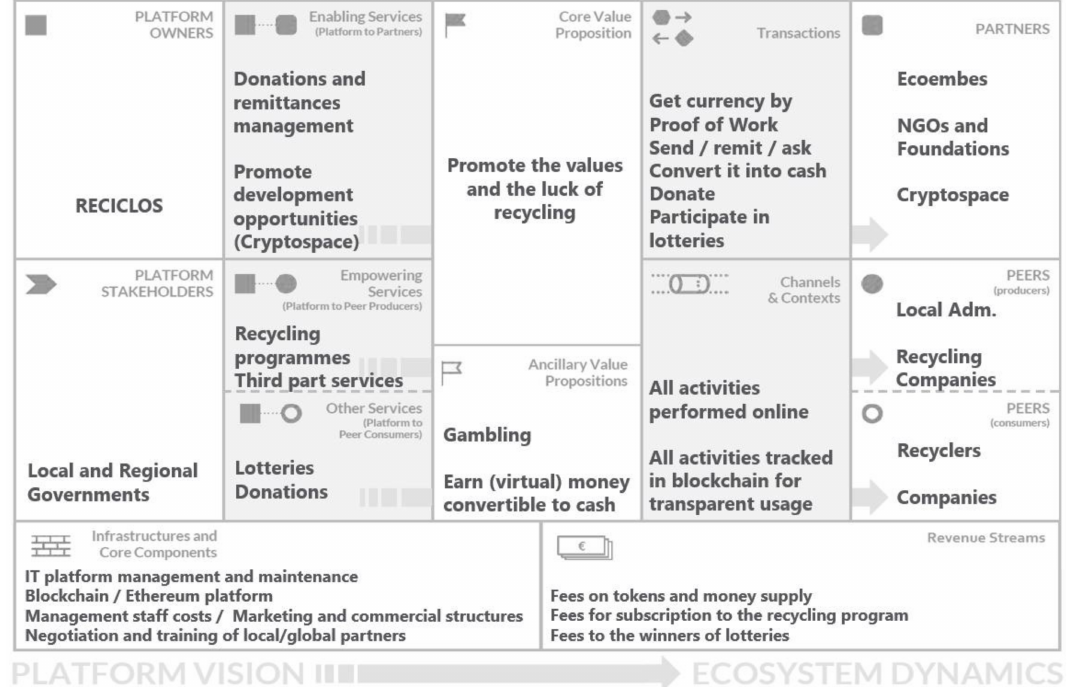
Figure 6. RECICLOS—Business model platform. (Note: own elaboration based on